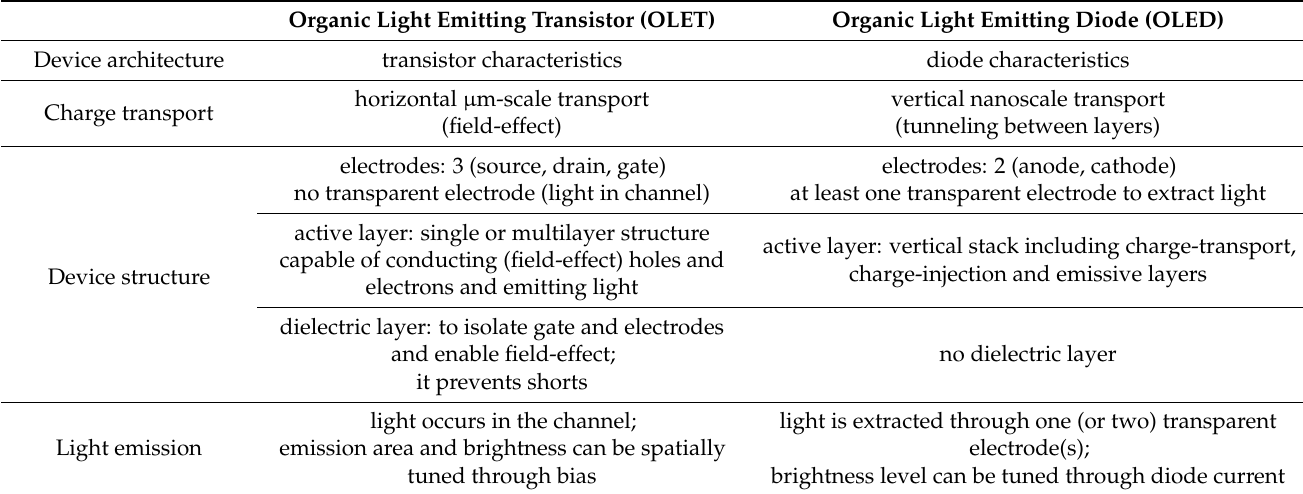
Table 1. OLET vs. OLED features. Summary of the features of organic light emitting transistors and organic light emitting diodes in terms of charge transport, device architecture and light emission